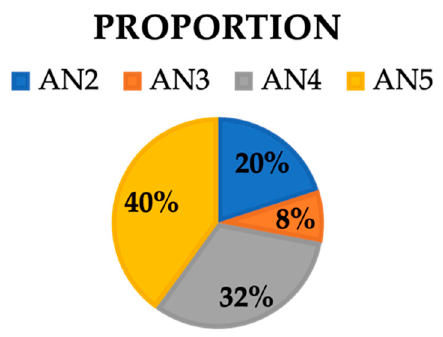
Table 2. The number of each type of nozzle.